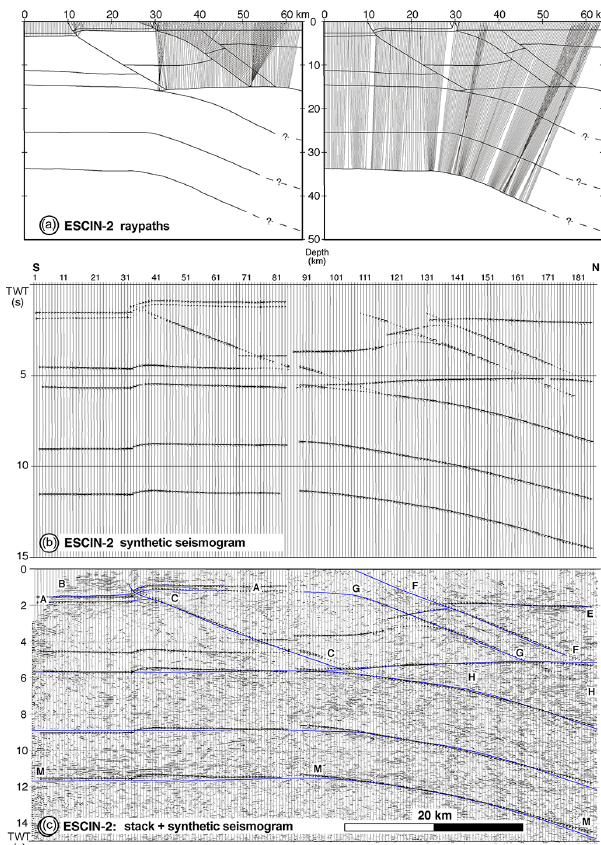
Figure 8. (a) Ray-path plot of normal incidence ray tracing to different interfaces in the final ESCIN-2 velocity depth model in Fig. 9b. Note the areas with no theoretical ray coverage under the Cantabrian Mountains. (b) Synthetic seismogram obtained from normal incidence ray tracing showing the seismic response of the same velocity–depth model. (c) Synthetic seismogram of the fi- nal model superimposed on ESCIN-2 and the boundaries of the velocity–depth model. It shows a good match between the real and synthetic seismic